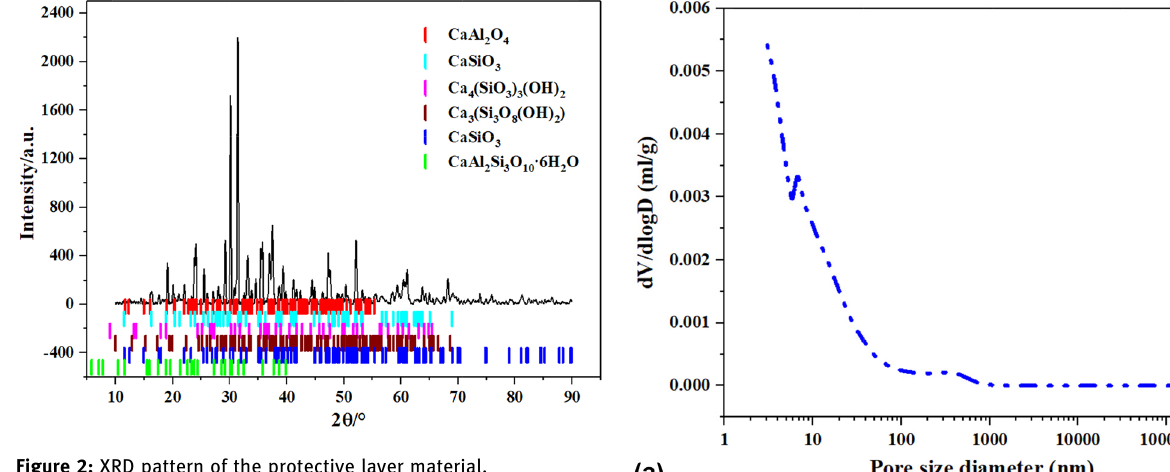
Figure 2: XRD pattern of the protective layer material.